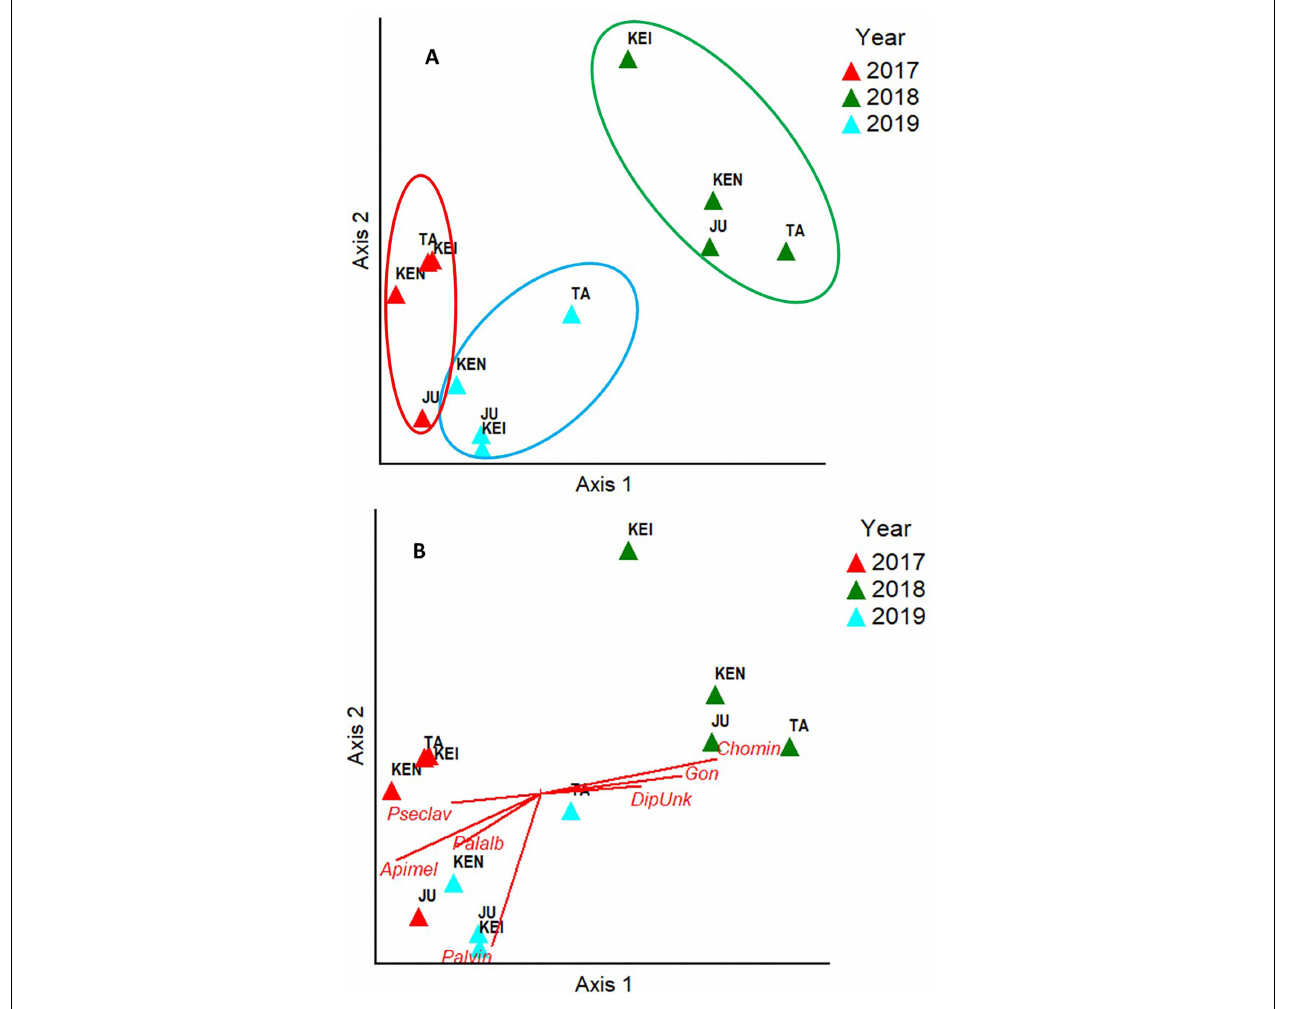
FIGURE 2 | Non-parametric multidimensional scaling analysis (NMS) based on Bray-Curtis similarity index evaluating differences in insect species composition among years and fields (Julie, Keitt, Kent, Tommy Atkins). (A) Observation groupings based on within year similarities. (B) Correlations lines showing the strongest associations between insect species and multivariate axes based on insect species abundance. See Table 2 for insect